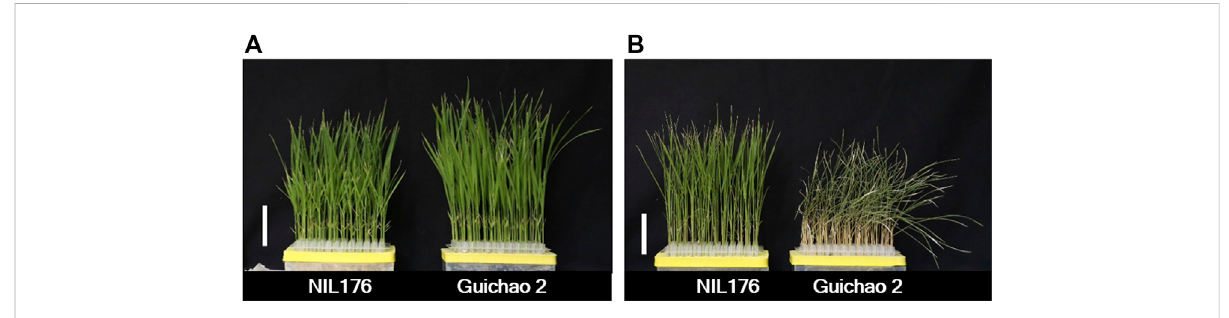
FIGURE 3 Phenotypesofchilling tolerance between NIL176 andGuichao2. (A) :Phenotypic comparisonofNIL176 andGuichao2 at28 ° C. (B) :Phenotypic comparison of NIL176 and Guichao 2 after cold stress.